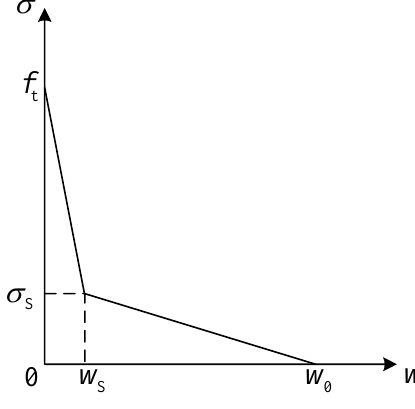
Figure 3. Bilinear softening curve.